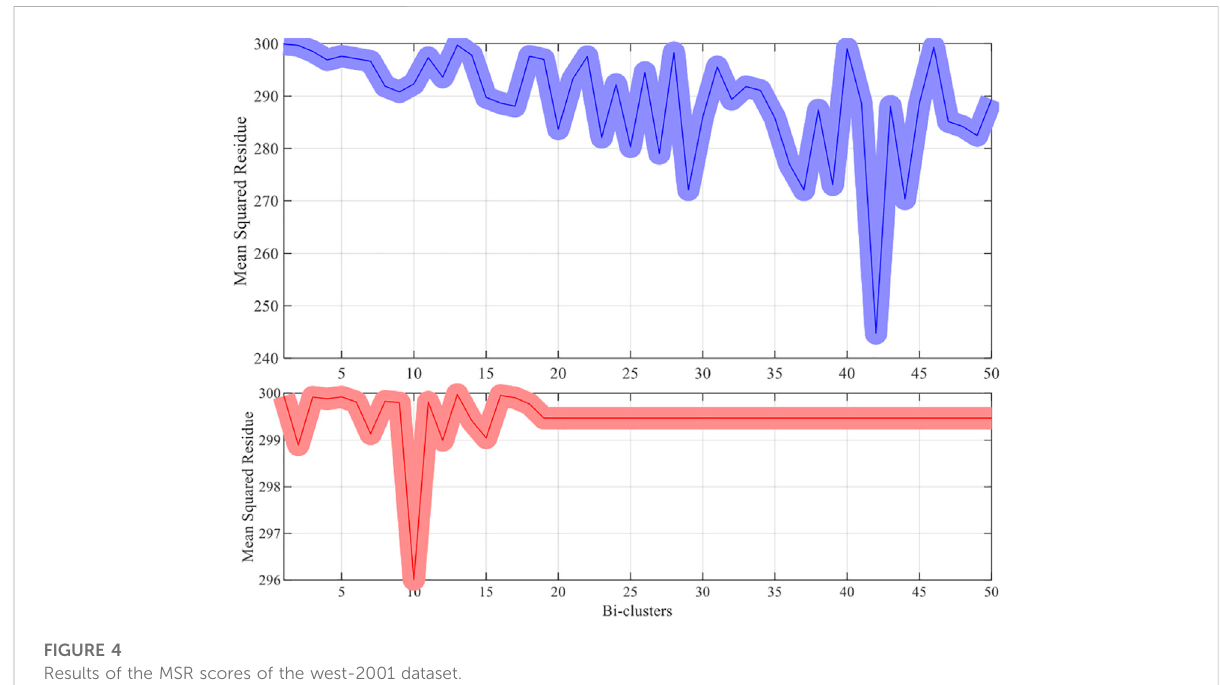
FIGURE 4 Results of the MSR scores of the west-2001